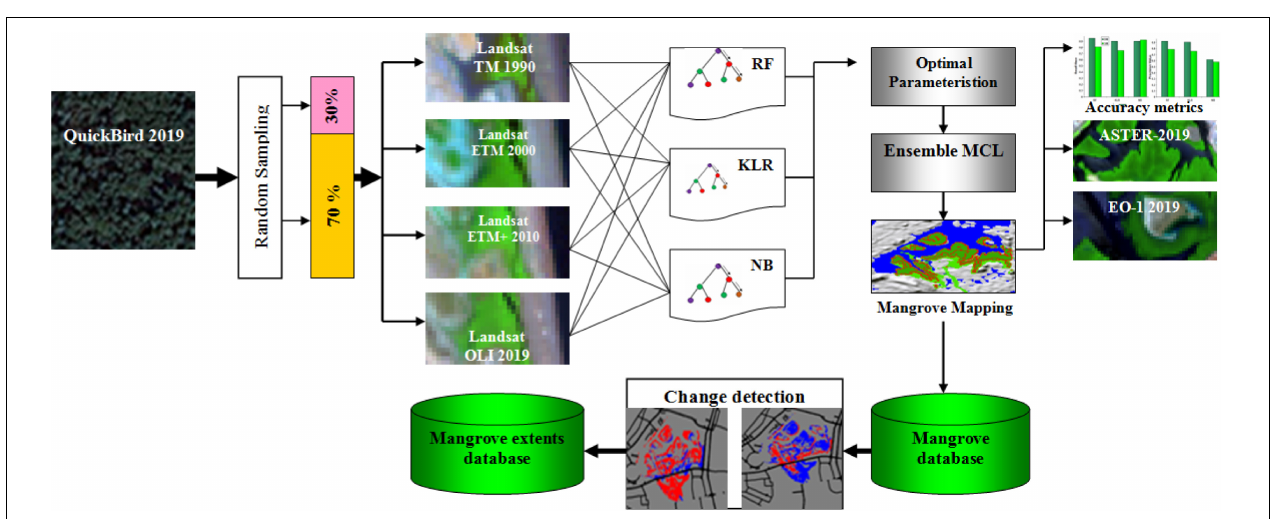
FIGURE 3 | RGB 541 band combination of Landsat image of the NUAE and zooms of the mangrove locations distributed along the eastern and western coastal areas in the NUAE.